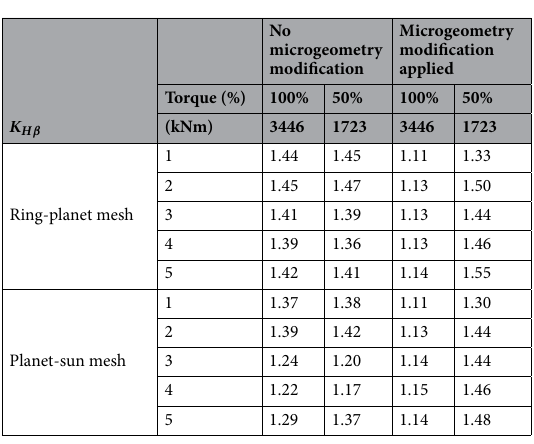
Table 6. K H β of the flexible pin model with and without microgeometry modification under the rated and partial load condition.